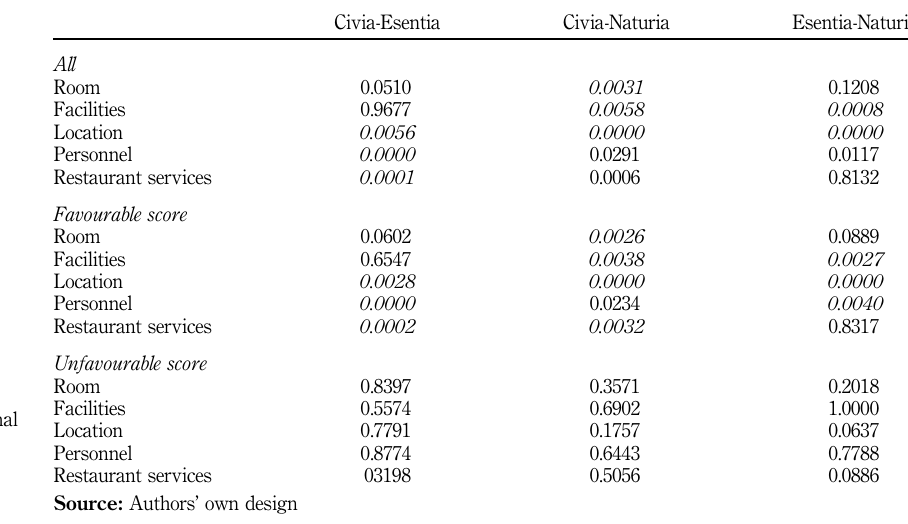
Table VII. p- values of the χ 2 test for proportional differences in the mention of items according to Parador